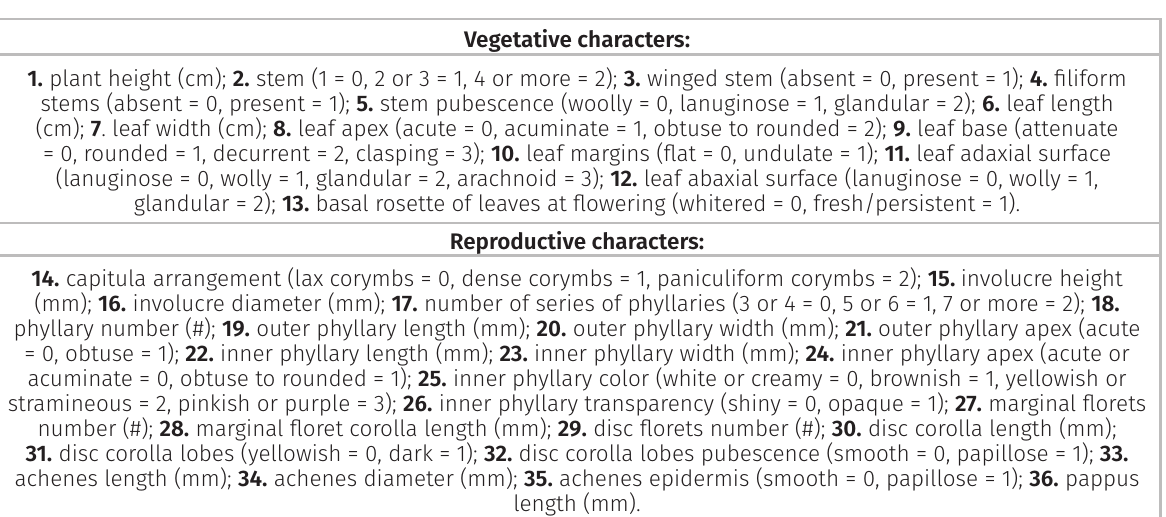
Table I. Morphological characters and character states evaluated in the